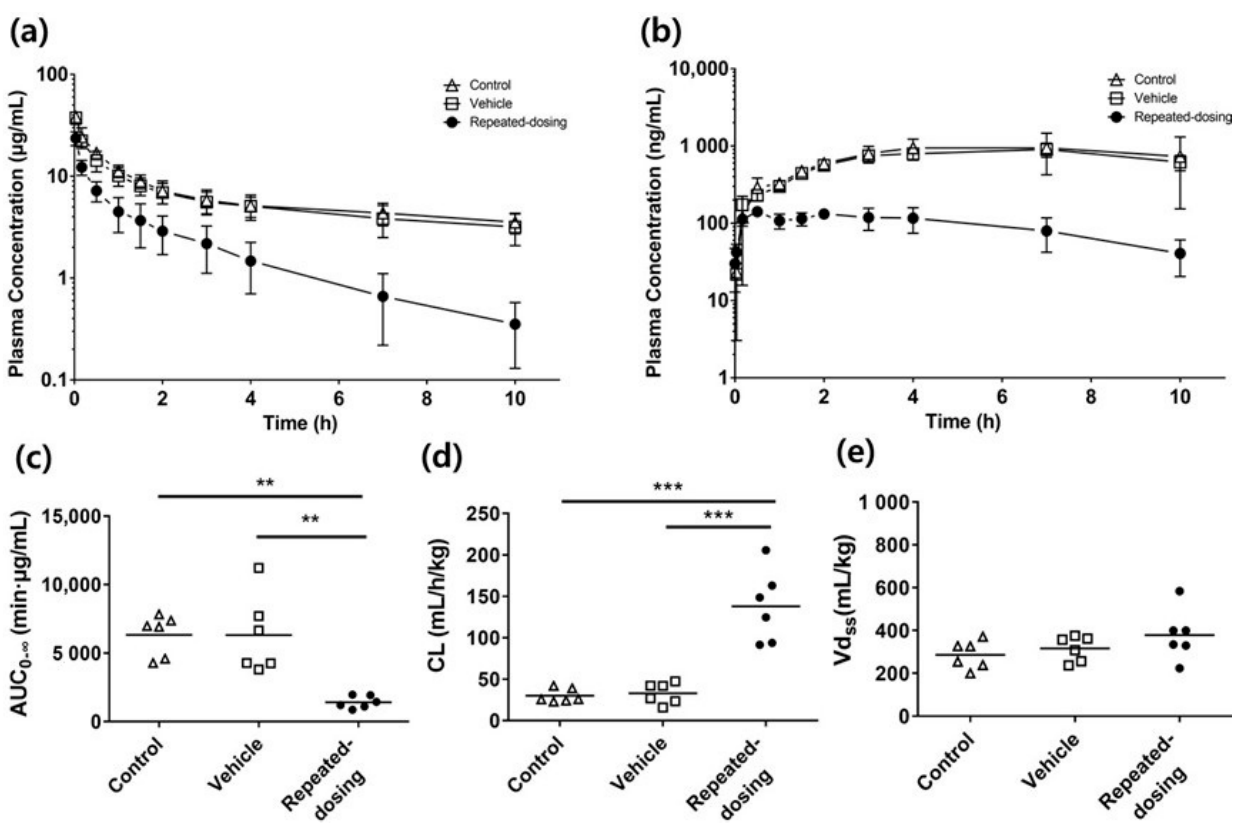
Figure 2. ( a , b ) Mean plasma concentration–time curve of SCR430 after IV ( a ) or IP ( b ) administration at a dose of 3 mg kg − 1 ( △ , control (without a dosing vehicle or SCR430) group; □ , vehicle (vehicle only, 14 days, PO) group; ● , repeated-dosing (SCR430 30 mg/kg, 14 days, PO) group ( n = 6). ( c – e ) Comparison of the control, vehicle, and repeated-dosing groups’ pharmacokinetic parameters. The AUC from time 0 h to infinity (AUC 0– ∞ ) ( c ), the total plasma clearance (CL) ( d ), and the steady-state volume of distribution (Vd ss ) ( e ) were compared. A one-way ANOVA statistical analysis was used for the statistical analysis, followed by a Turkey’s post-hoc test, where appropriate. The stars indicate statistical significances, ** p < 0.01, *** p < 0.001. Table 1. Comparison of the pharmacokinetic parameters between the control (without a dosing vehicle or SCR430, n = 6), vehicle (vehicle only, 14 days, PO, n = 6), and repeated-dosing (SCR430 30 mpk, 14 days, PO, n = 6) groups. The data are presented as mean ± standard deviation (relative standard error